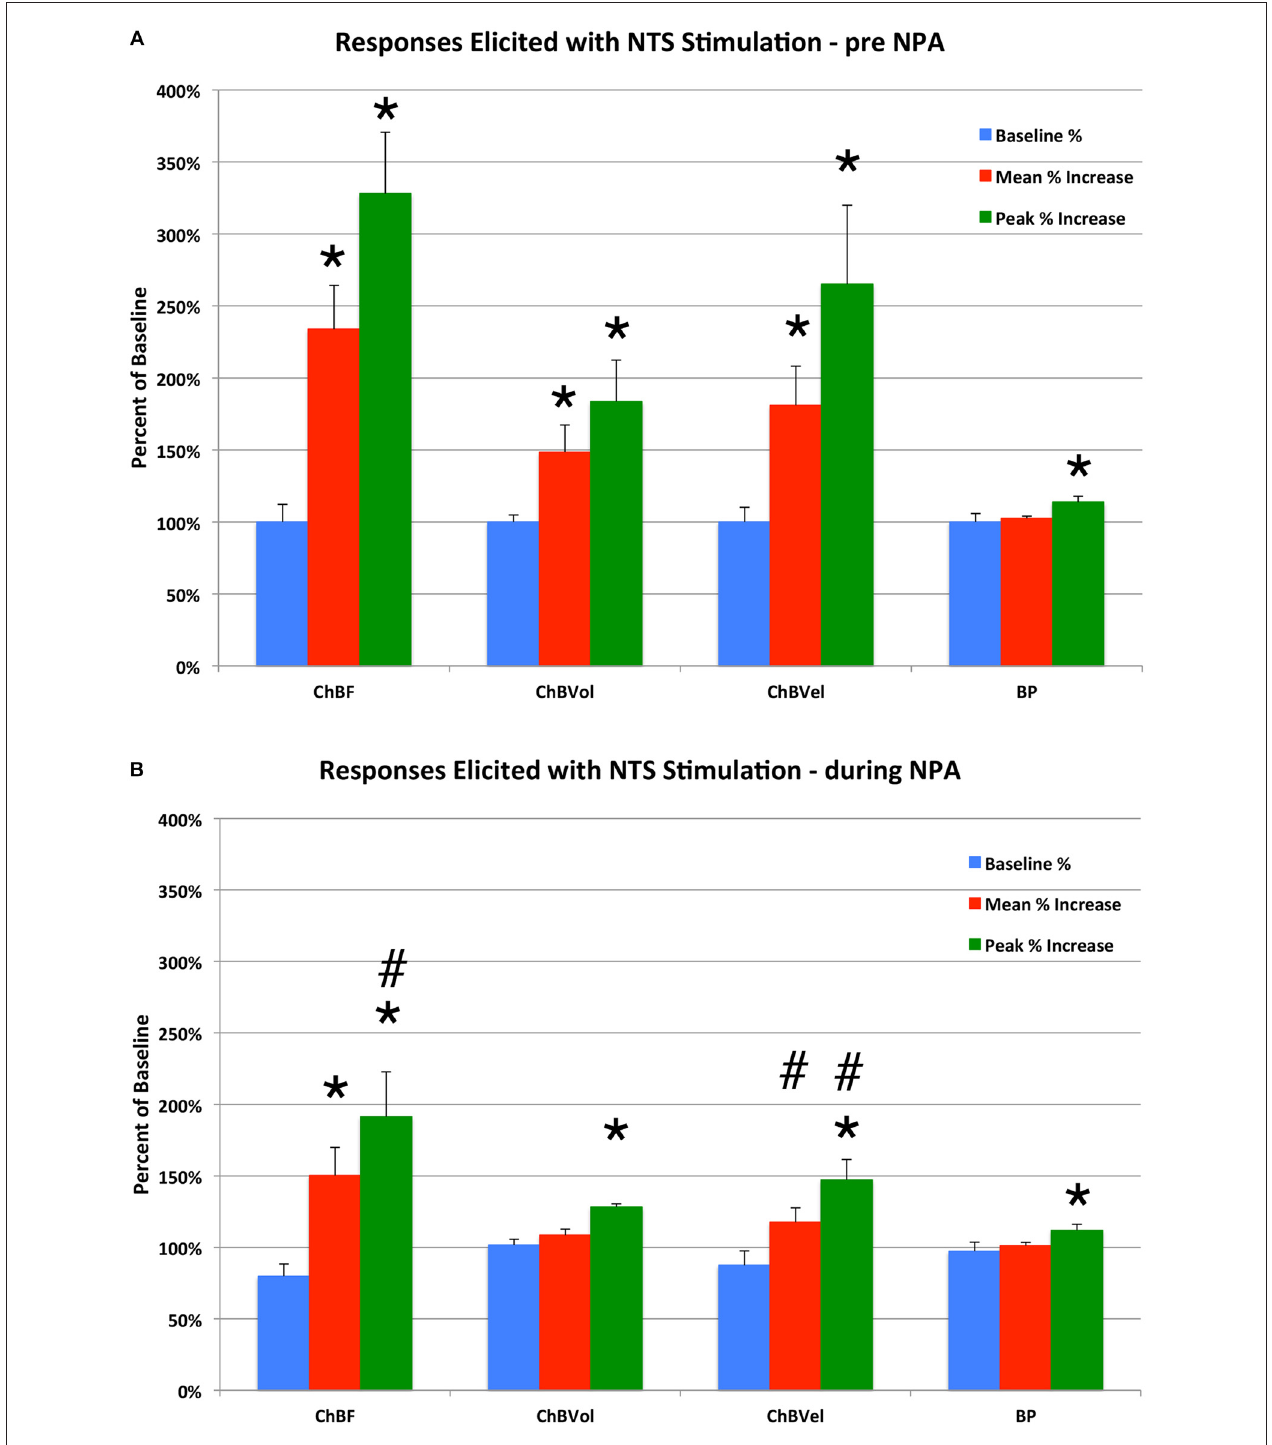
FIGURE 6 | Histogram showing the mean and peak ChBF, ChBVol and ChBVel responses and ABP responses to NTS stimulation at effective 100 µ A anodal stimulation sites, expressed as a percent of basal ChBF, ChBVol and ChBVel responses and ABP, prior to N ω -propyl-l-arginine (NPA) administration (A) and after NPA administration (B) . Note that NTS stimulation prior to NPA yielded significant ChBF, ChBVol and ChBVel increases but had no effect on ABP, and that NPA attenuated the ChBF, ChBVol and ChBVel increases but had no effect on ABP. Asterisks indicate significantly different from baseline, and ampersands indicate significantly less than pre-NPA. Error bars represent the